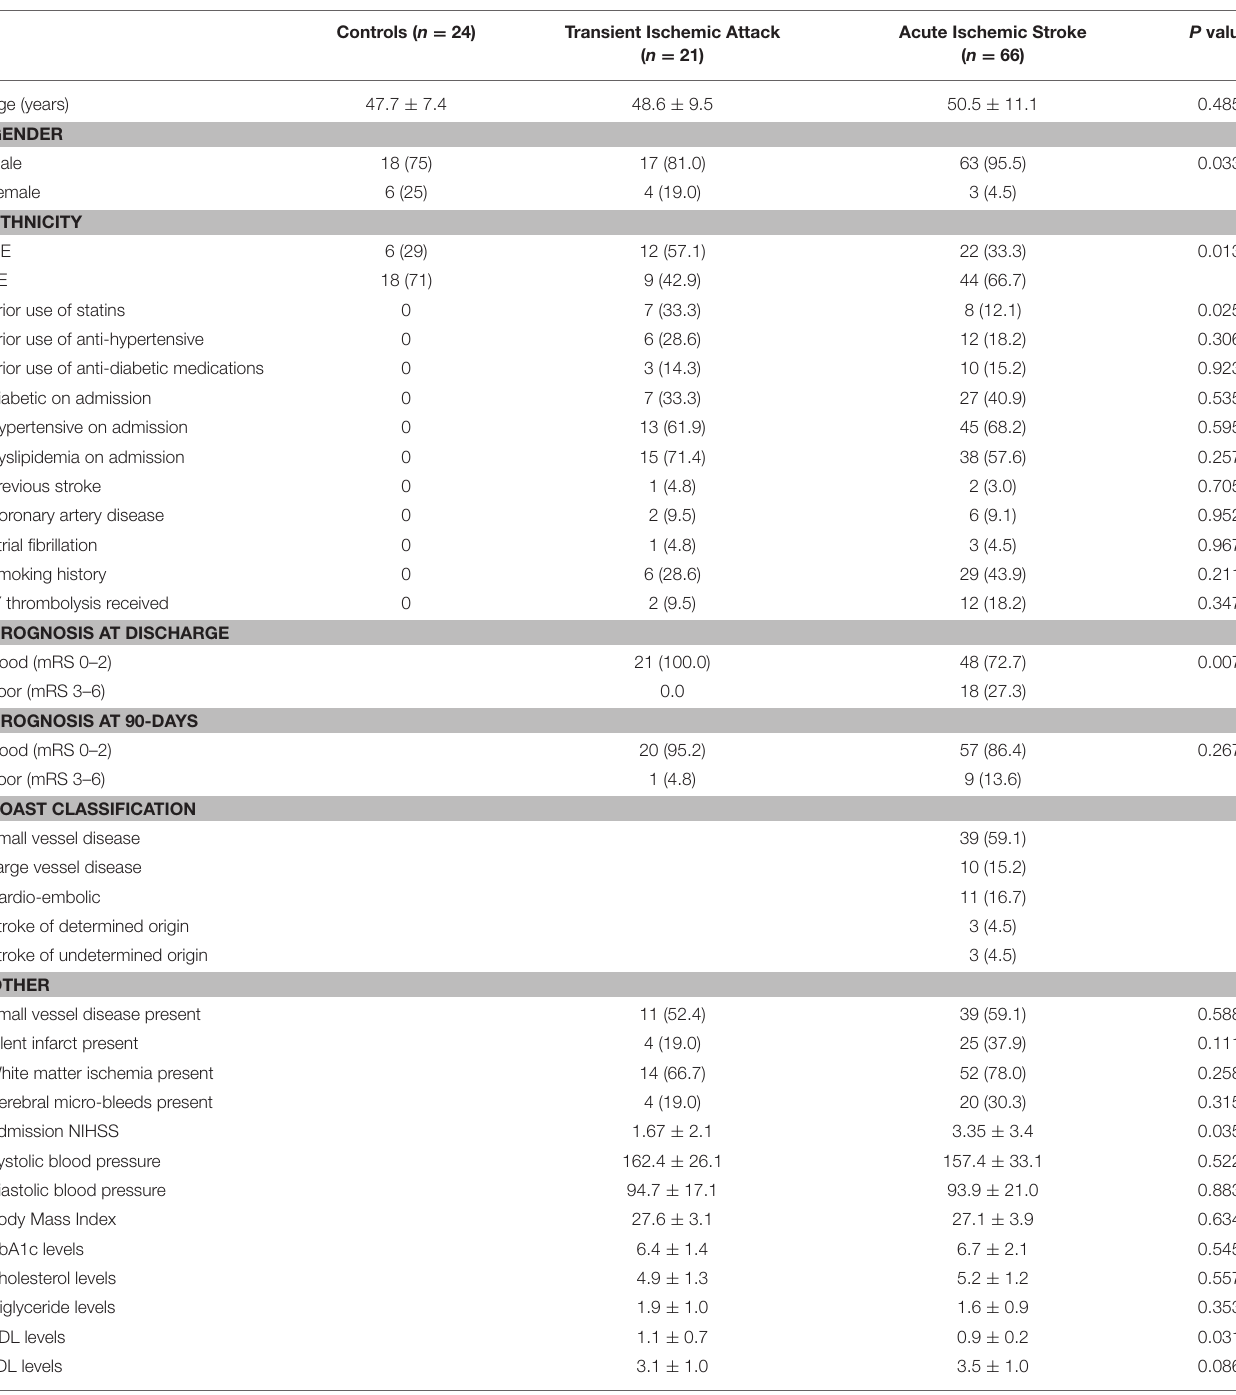
TABLE 1 | Baseline Characteristics of subjects enrolled in the study.